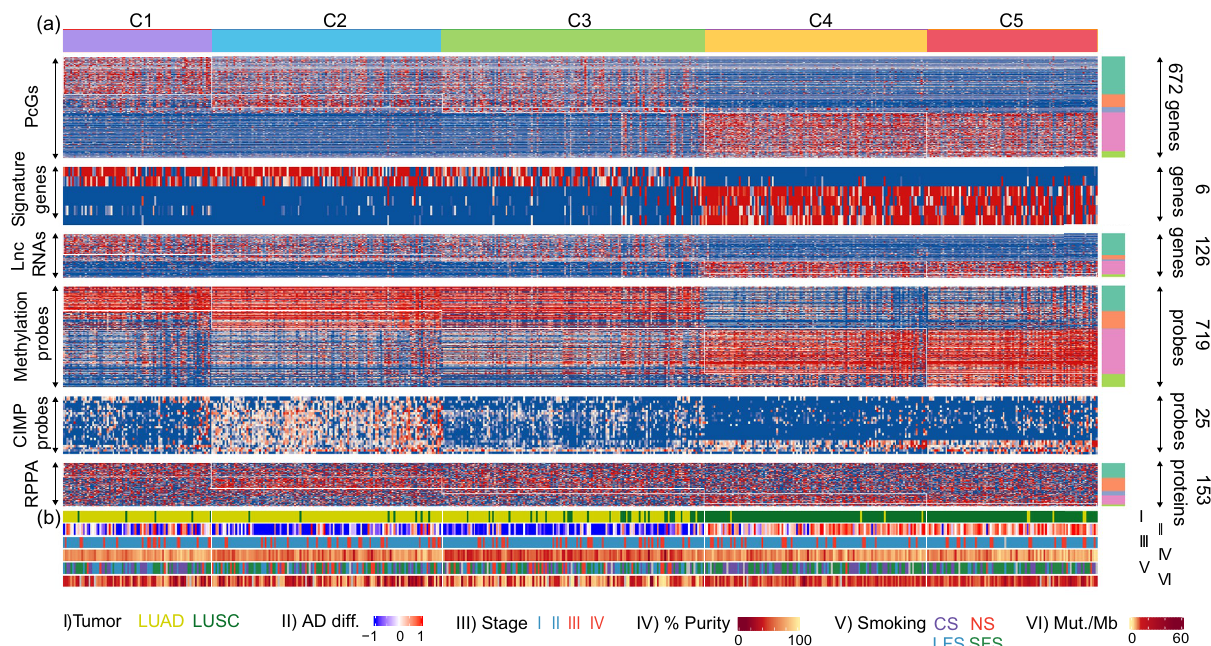
Figure 3. Characterization of different molecular levels of evidence. ( a ) Heatmap indicating the expression of protein coding genes (PcGs), LUAD-LUSC signature genes (NKX2-1, KRT7, KRT5, KRT6A, SOX2, TP63), long non-coding RNAs (lnc RNAs), CpG probes, CIMP probes, and protein expression in the subgroups obtained by multi-omics clustering. ( b ) Heatmap showing TCGA subtype, AD differentiation, pathological stage, tumor purity, smoking status (NS, lifelong never-smokers; LFS, longer-term former smokers greater than 15 years; SFS, shorter-term former smokers; CS, current smokers), and mutation rate in the multi-omics